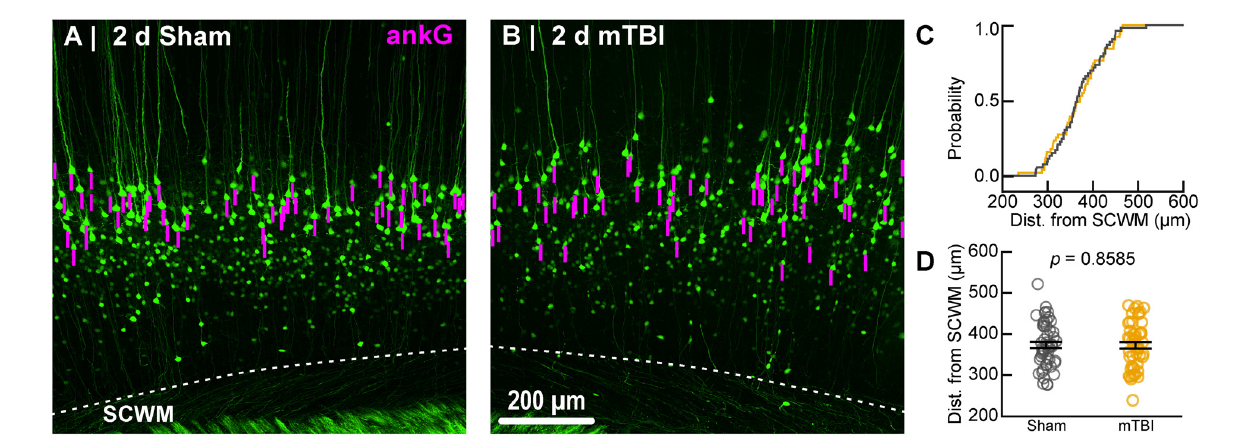
FIGURE 5 | Sampling distribution of intact YFP+ pyramidal neurons for ankG quantitative analysis. (A,B) Superimposed maximum intensity projections of 10 × overview images for sham (A) and mTBI (B) . The intact YFP+ pyramidal neuron sampling distribution (magenta bars) is symmetric with respect to the SCWM. (C) Cumulative frequency distribution plot shows a high degree of overlap between sham (gray) and mTBI (gold). (D) Quantitative analysis confirmed no sampling difference. Statistics: multilevel analysis with animals as a random variable. Data summarized with means and standard error of the mean (SEM) error bars.